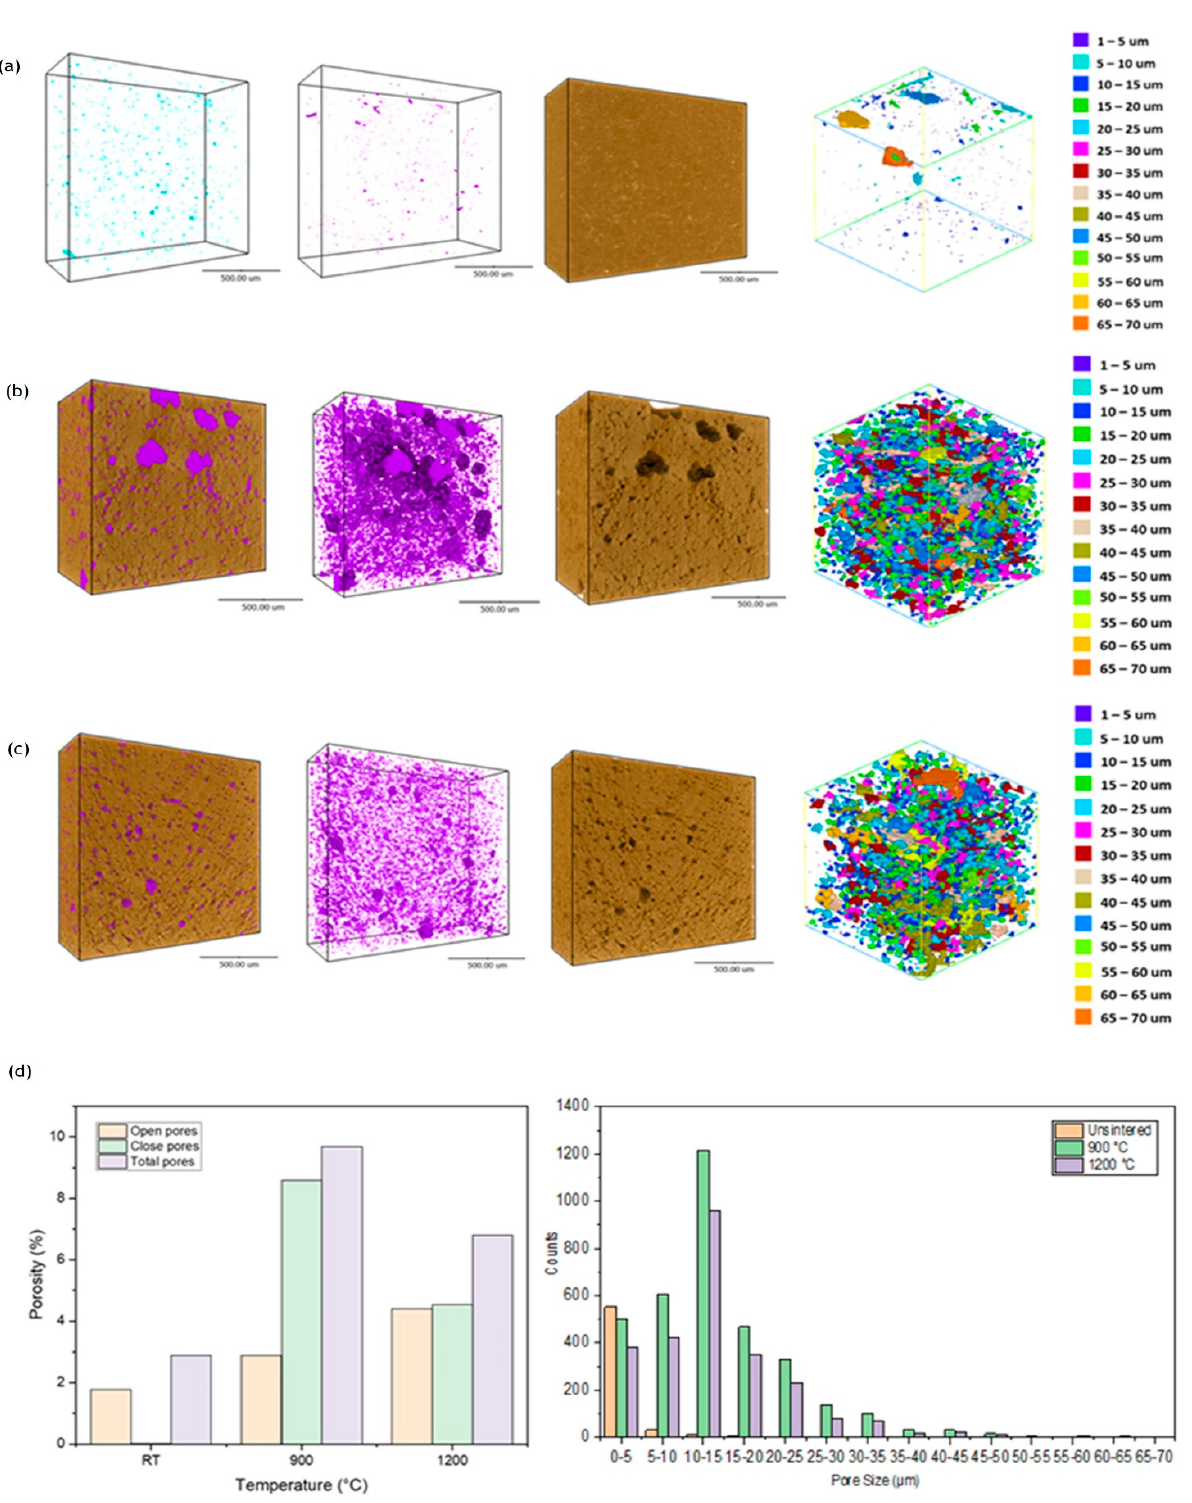
Figure 6. Three–dimensional pore structures with pore distributions of ( a ) unsintered kaolin-based geopolymer, geopolymer-based nepheline ceramics sintered at ( b ) 900 °C and ( c ) 1200 °C, and ( d ) pore contents and pore size counts.